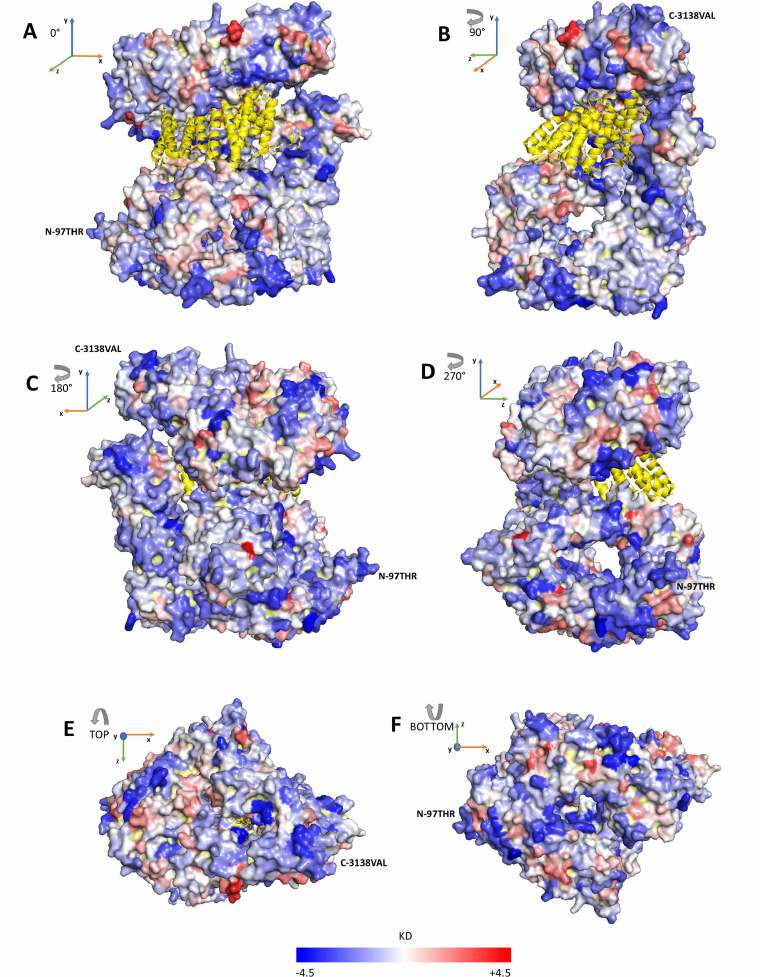
Figure 2. Solvent accessible surface of huntingtin. The Figure depicts the protein structure of huntingtin in complex with HTT -associated protein 40 (HAP40 , colored in yellow) [19] and captured by six different views: with a clockwise rotation of the protein around the vertical axis with 90-degree steps ( A – D ) and the top and bottom views with respect to the vertical axis ( E , F ). The huntingtin surface is colored according to the average KD value obtained for each residue by averaging KD values over the 6 Å-radius neighborhood centered at the residue (KD, Kyte and Doolittle scale) [32]. The KD coloring scheme follows the blue–white–red palette (blue KD = − 4.5, white KD = 0, red KD = +4.5). N- and C-termini of the protein are